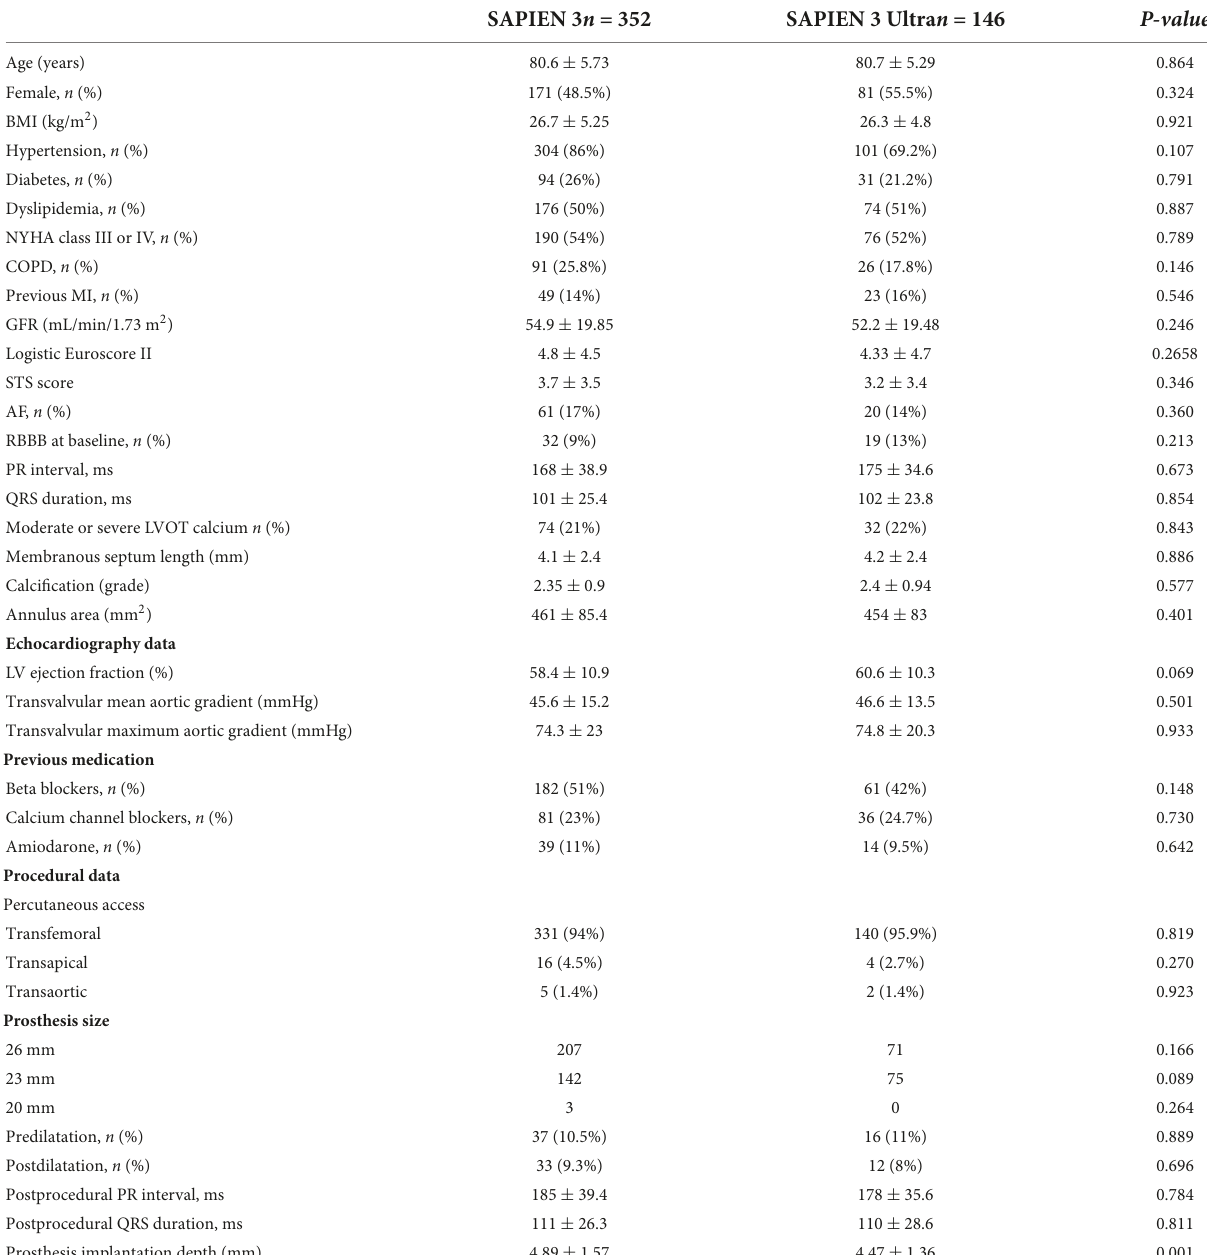
TABLE 2 Comparison of baseline characteristics and procedural data between